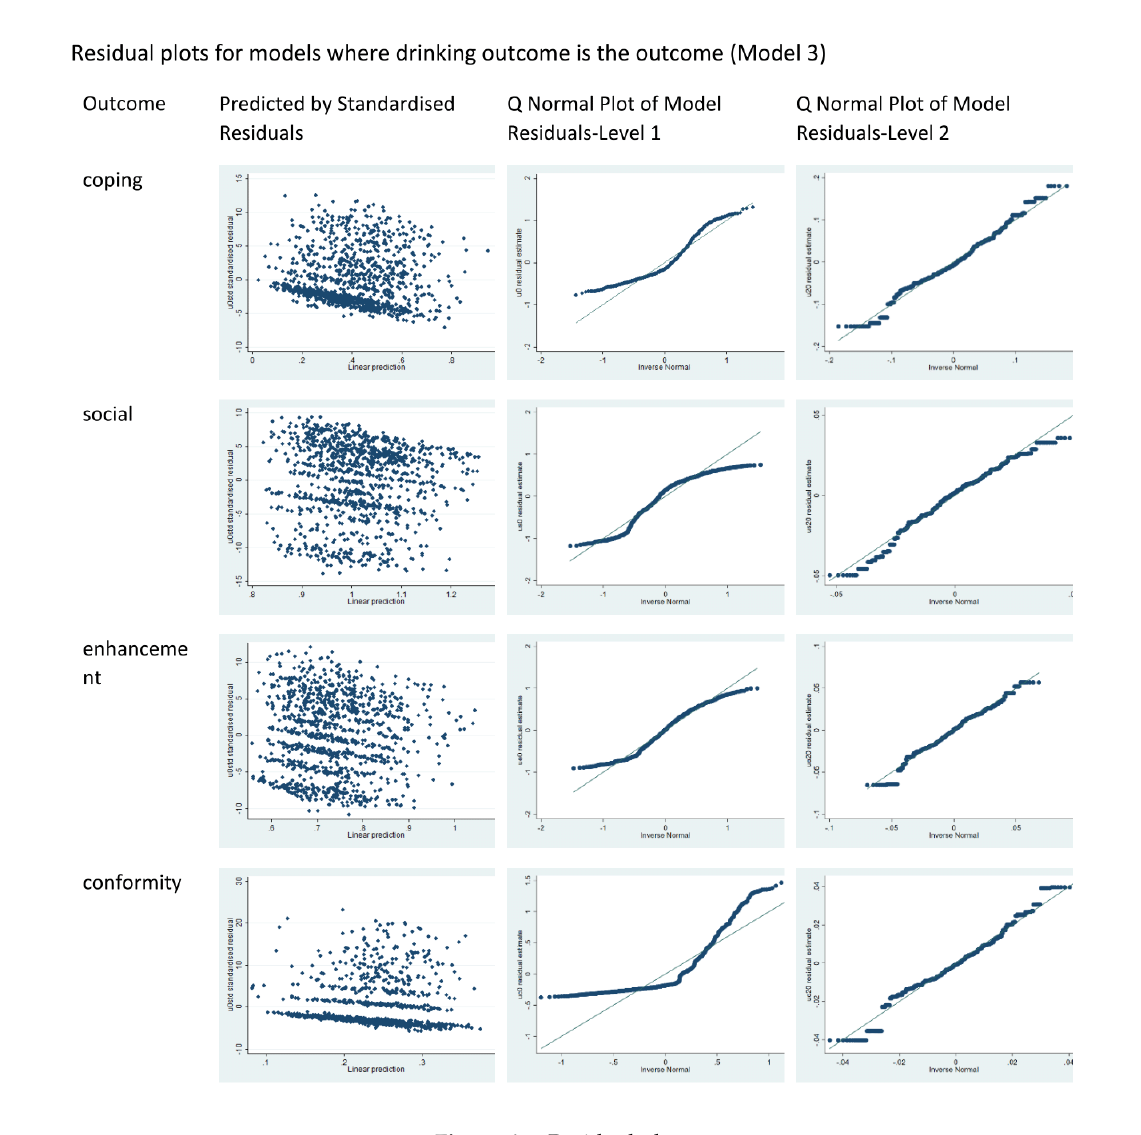
Figure A2. Residual plots. Table A1. Cross-classified model for coping drinking